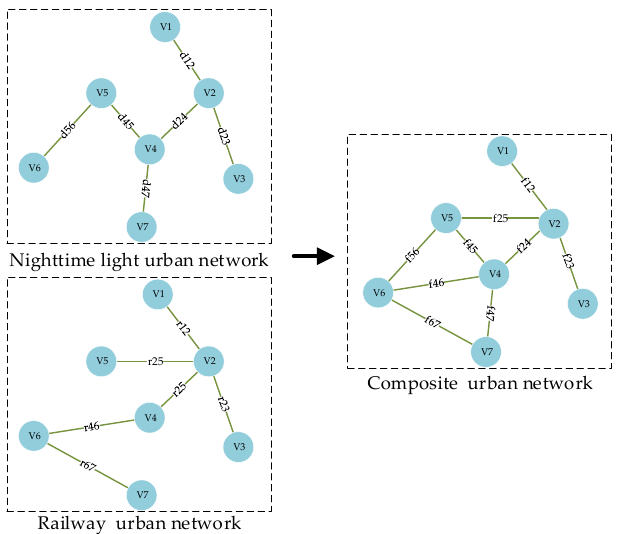
Figure 6. Schematic diagram of composite urban network construction.